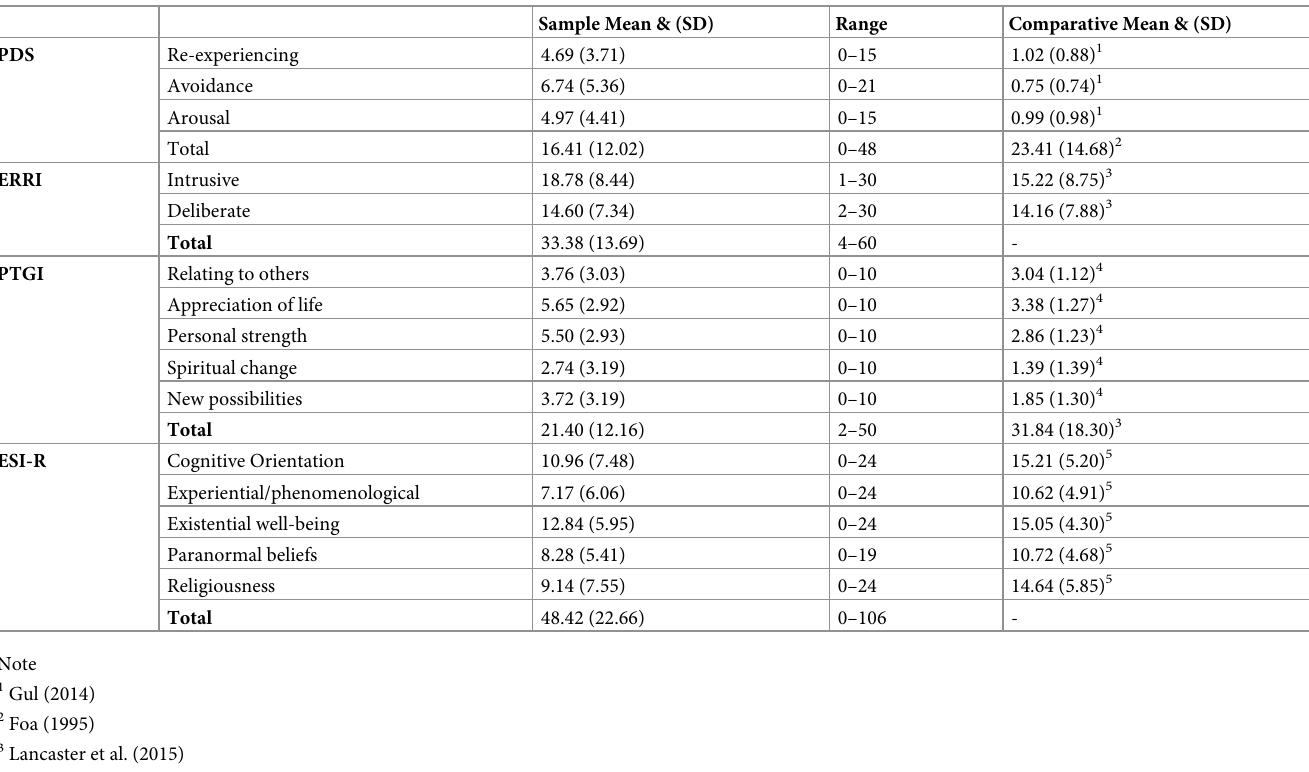
Table 2. Mean & SD scores of main